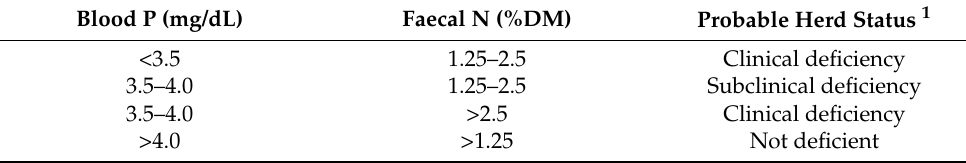
Table 3. Interrelationship between the values of blood P and faecal N of cattle raised on pastures during the middle to the end of the rainy season and not supplemented with